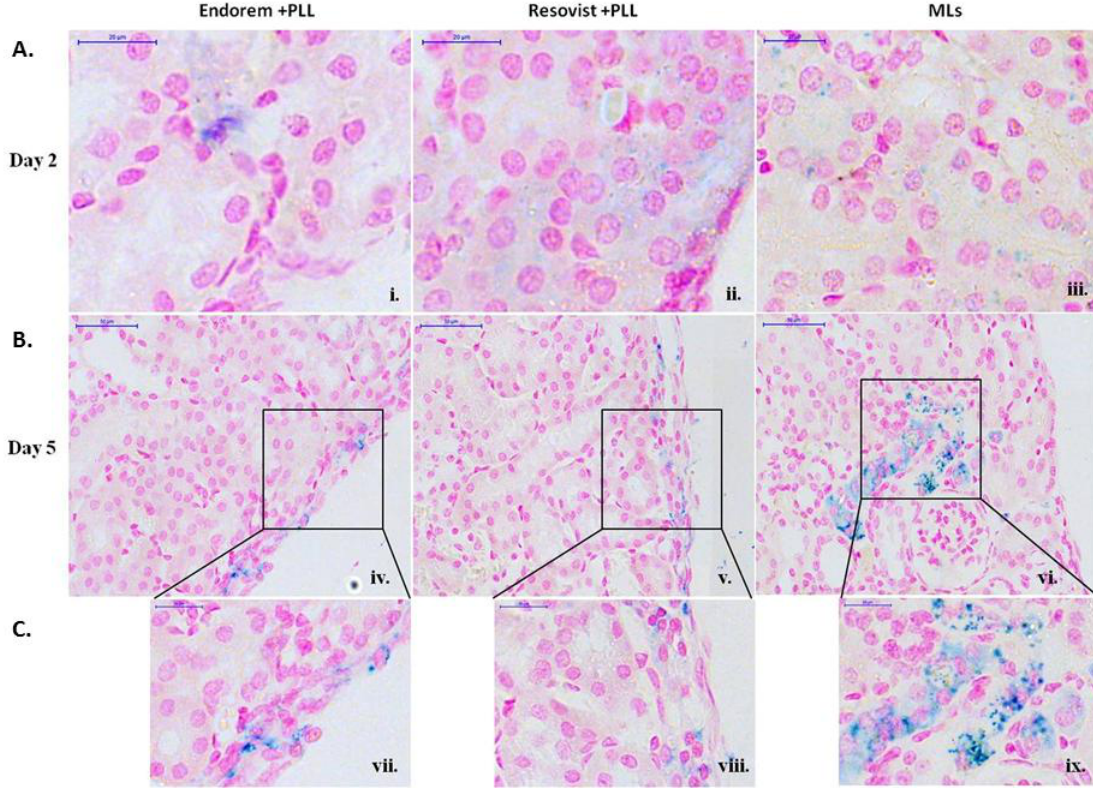
Figure 7. Prussian blue staining: ( A ) ( i – iii ) Prussian blue staining of kidney tissue clearly indicated the presence of blue stain along the sub-capsular region by day two for all labeling conditions. Figures ( B ) ( iv – ix ) show staining for later time points after transplantation. Prominent staining was observed for the PIs labeled with MLs for up to five days, which was not the case for the other labeling conditions. Figure ( C ) ( vii – ix ) shows higher magnification images for day five. Scale bar: ( i – iii ) and ( vi – ix ): 20 μm, ( iv – vi ): 50 μm.